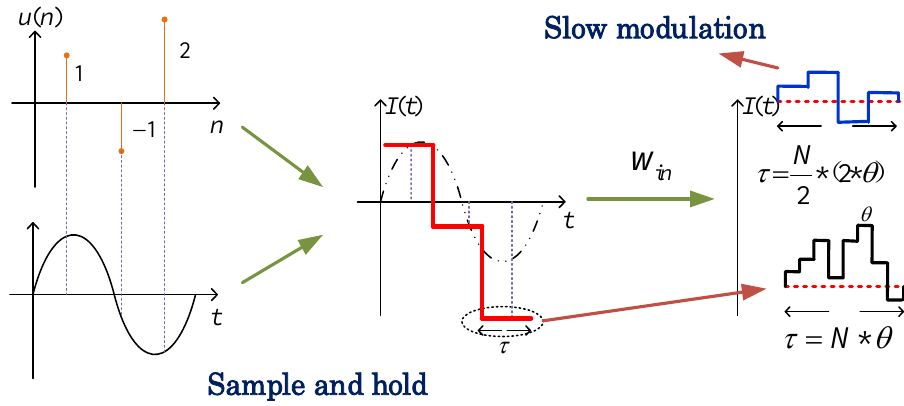
Figure 3. Schematic diagram of the input signal pre-processing process.